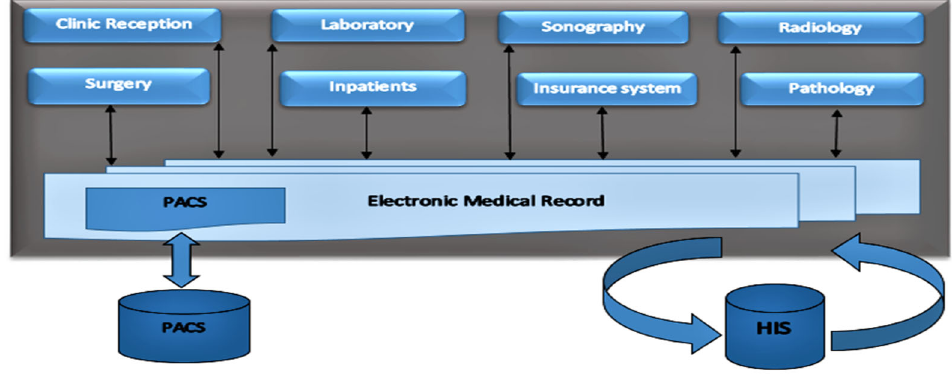
Figure 1. The data structure in HIS.